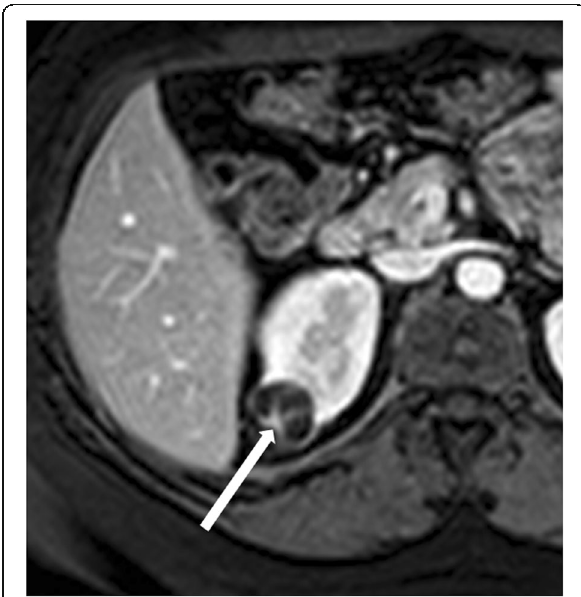
Fig. 9 Bosniak category IV renal cyst. Axial contrast-enhanced T1- weighted MR image shows a lesion with a peripheral, enhancing, nodule